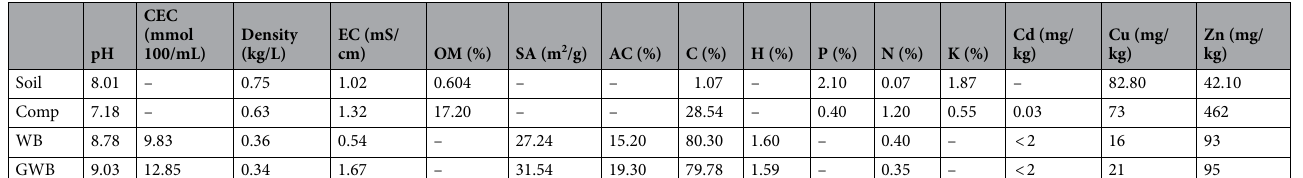
Table 5. Physiochemical parameters of soil, compost, wood biochar, green waste biochar. CEC cation- exchange capacity, EC electrical conductivity, OM organic matter, SA surface area, AC ash contents, Comp compost, WB wood biochar, GWB green waste biochar. – Parameters were not